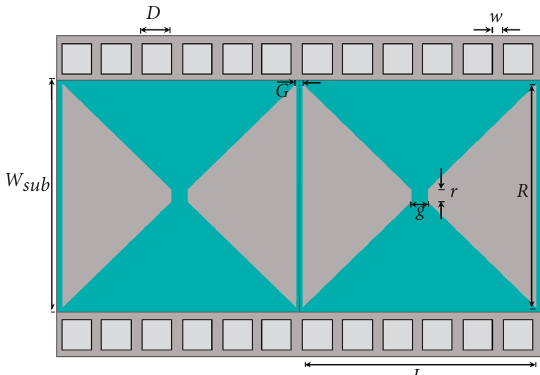
Figure 5: A capacitive FSS made with square metal patches.